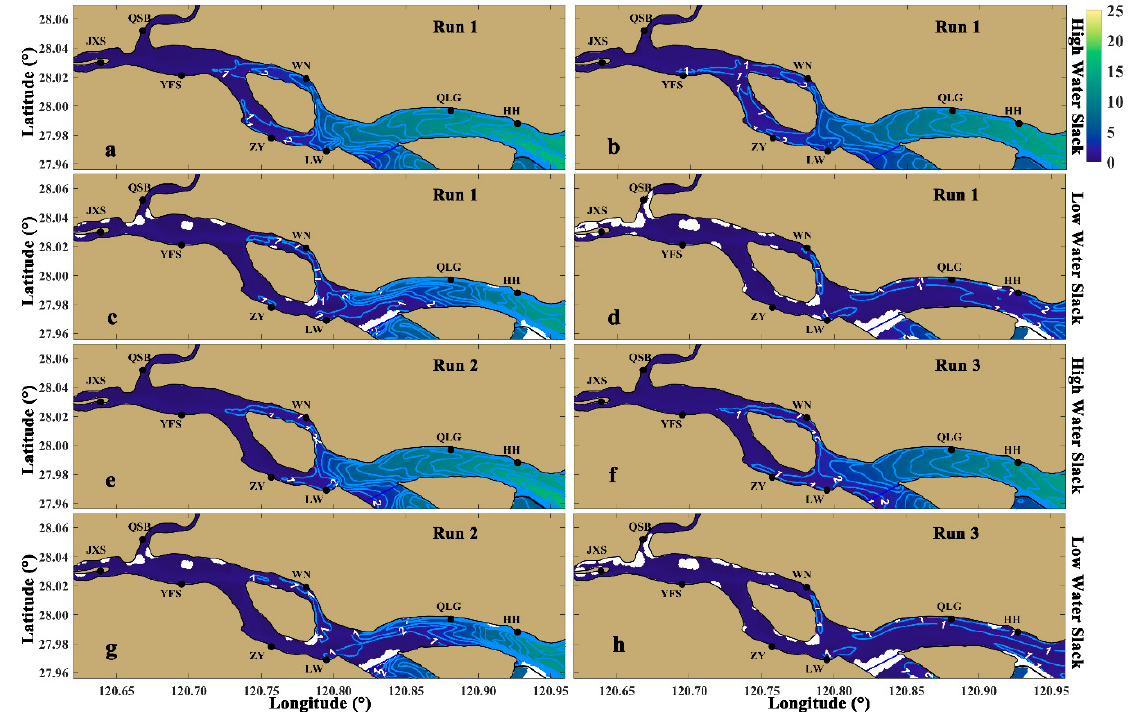
Figure 8. Distribution diagram of bottom salinity (filled contour, unit: PSU) under ( a – d ) the low-discharge condition and ( e – h ) PRD condition at high water slack and low water slack. The salinity is in 1-PSU intervals. Left panels are during neap tide, and right panels are during spring tide. White areas indicate tidal flat.